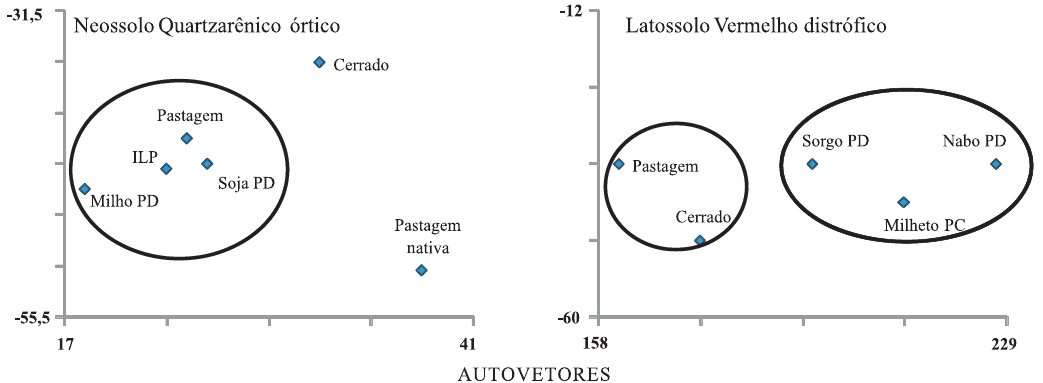
Figura 1. Dispersão dos diferentes sistemas de uso e manejo e agrupamento pelo método de Tocher das duas primeiras variáveis canônicas no Neossolo Quartzarênico órtico e no Latossolo Vermelho distrófico. ILP: integração lavoura-pecuária; PD: plantio direto; PC: preparo